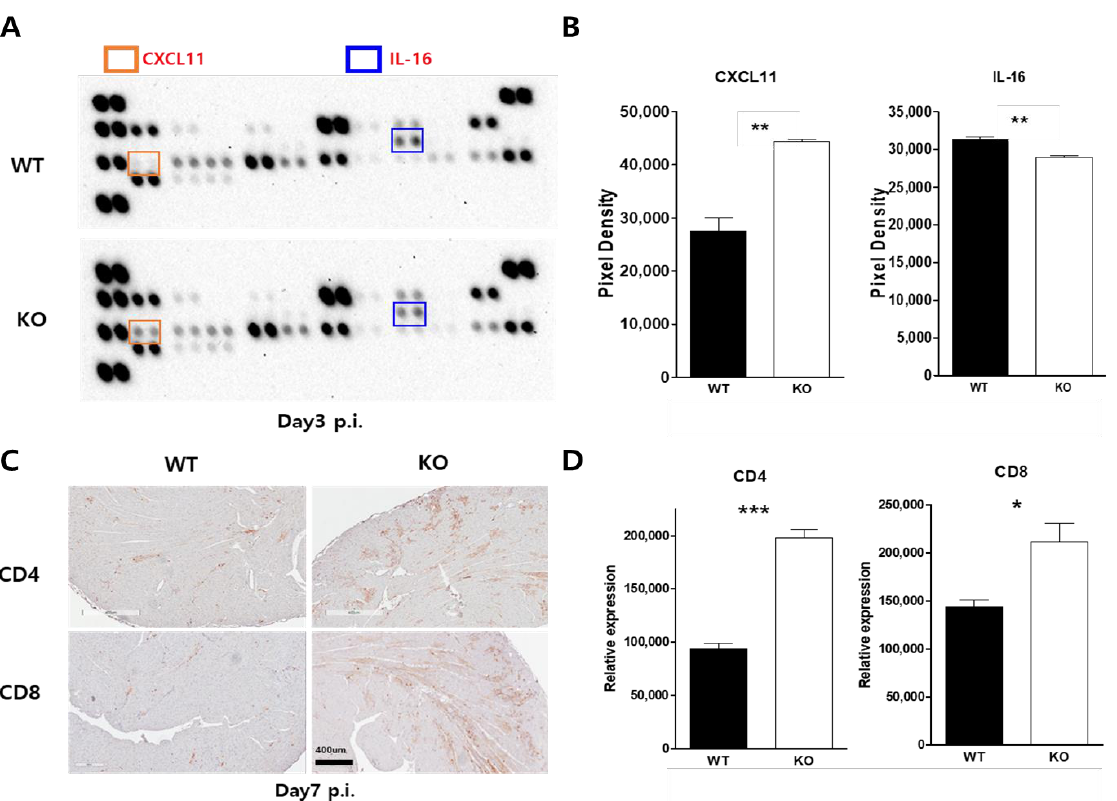
Figure 6. Macrophage CAR deficiency induced T-cell activation in CVB3 infection. ( A ) The serum was collected from WT and KO mice three days p.i. and then subjected to a chemokine multi-dot analysis system. ( B ) The chemokine dot density was quantified using ImageJ software. ( C ) Hearts were sectioned and subjected to immunohistochemistry. Brown stains indicate CD4- and CD8-pos- itive T lymphocytes in WT and KO mice hearts at day seven p.i. ( D ) Positive cells were quantified by ImageJ software. All data are expressed as the mean ± SEM from independent experiments. * p < 0.05, ** p < 0.01 and *** p < 0.001 according to a two- tailed Student’s t -test. 3. Discussion To examine the role of macrophage CAR expression in the pathogenesis of myocar- ditis, we generated mice with CAR KO using the Cre-LoxP recombination system with the murine lysozyme promoter Cre. Peritoneal macrophages (PMC) were then isolated to determine whether CAR expression affects macrophage polarization by LPS treatment or CVB3 infection. Our initial observation was that macrophage M1 polarity was upregu- lated in the macrophage-specific CAR KO mice with CVB3-induced myocarditis. How- ever, mice survival was improved, despite increased viral replication and inflammation lesions in the heart. This finding conflicts with previous results, raising the question of the mechanisms at work in these macrophage-specific CAR-deficient mice. The mechanisms involved in mediating the activity of the innate immune response remain unclear. Our results indicate that CAR was stimulated by the LPS and TNF- α treated mouse macrophage 264.7 cell line. This result implies that CAR may work as a sensor of inflam- mation in the early immune response. M1 polarized macrophage gene expression was increased in the peritoneal macrophage (PMC) in the thioglycollate-induced peritonitis model. In contrast, CAR-deleted knockout isolated PMCs attenuated the expression of the proinflammatory cytokine genes (IL-1 β , and TNF- α ) with LPS treatment. This may be be- cause they play important roles in regulating macrophage polarization in the early stage of LPS stimulation. In contrast, CVB3 infection led to M1 polarized gene expression even